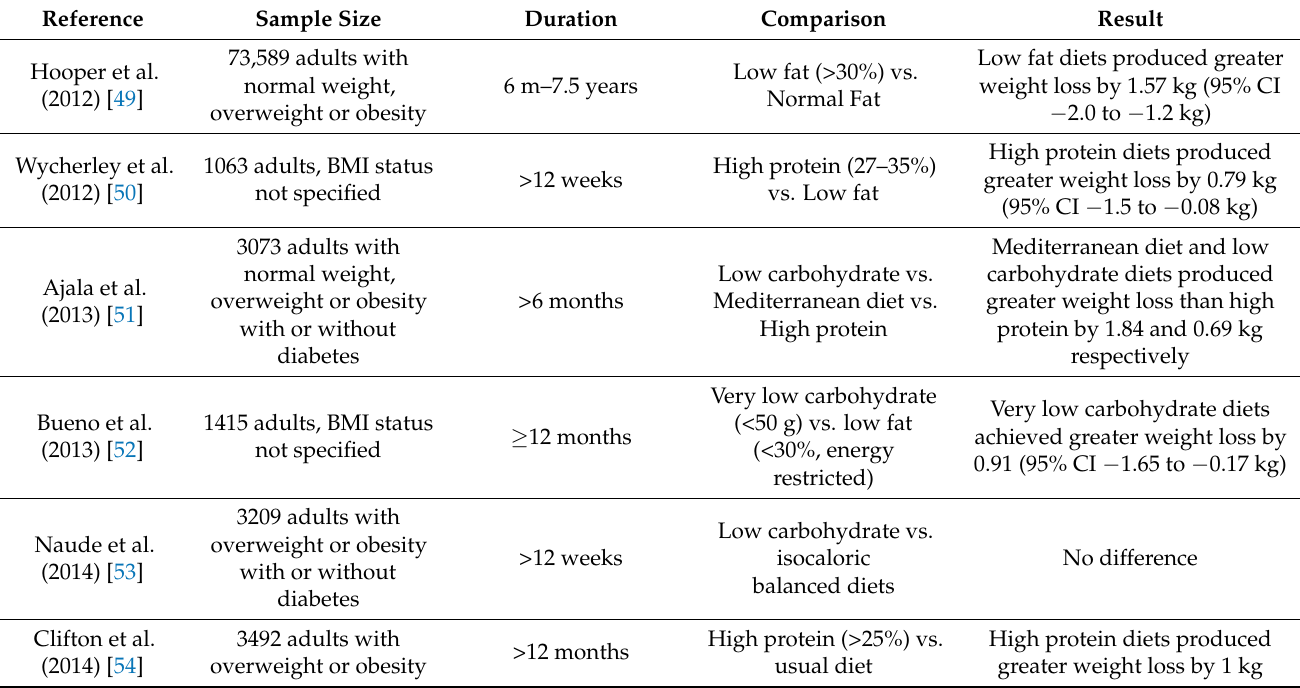
Table 2. Selected systematic reviews and meta-analyses comparing macronutrient diets for weight loss effectiveness.